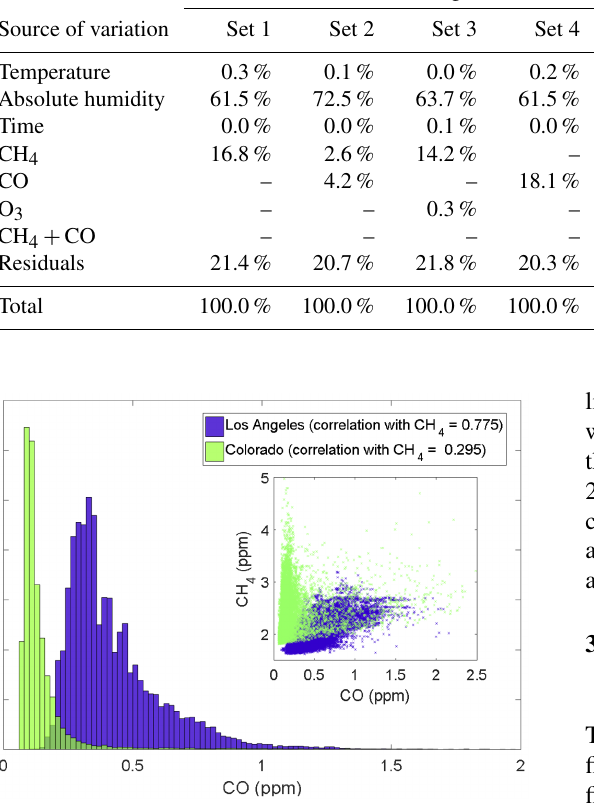
Figure 13. Histogram of carbon monoxide data from the two de- ployments and scatter plot of carbon monoxide data vs. methane data also from the two deployments. Note that all data in these two plots are from reference